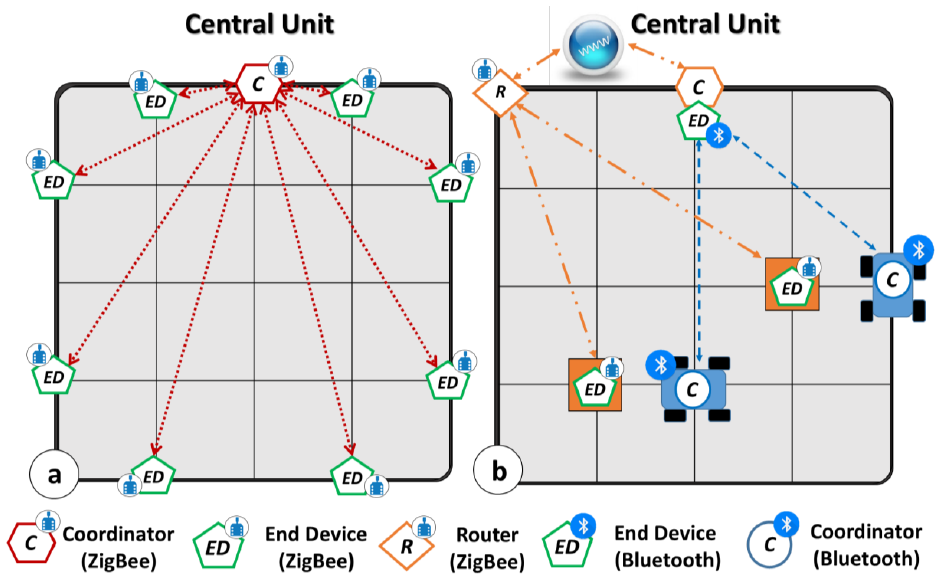
Figure 3. Communication Protocols: ( a ) Multipoint ZigBee Network for Environmental Control Unit; ( b ) Router-based ZigBee Network for pallets monitoring and Bluetooth point-to-point Displacement Unit management.